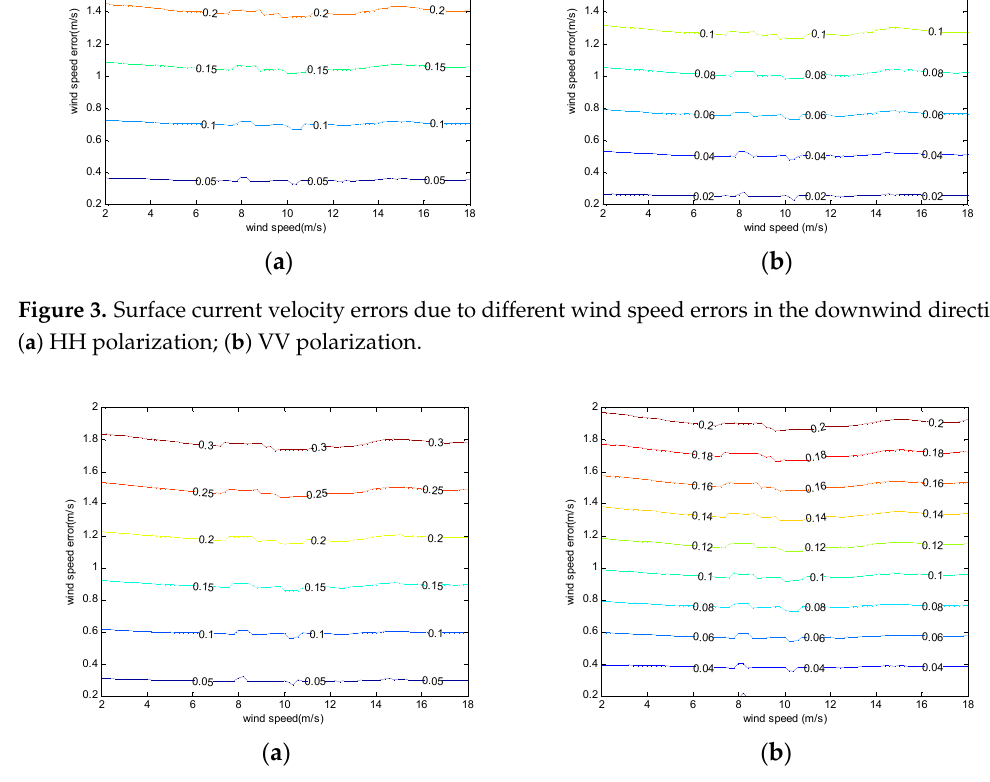
Figure 4. Surface current velocity errors due to different wind speed errors in the upwind direction: ( a ) HH polarization; ( b ) VV polarization.